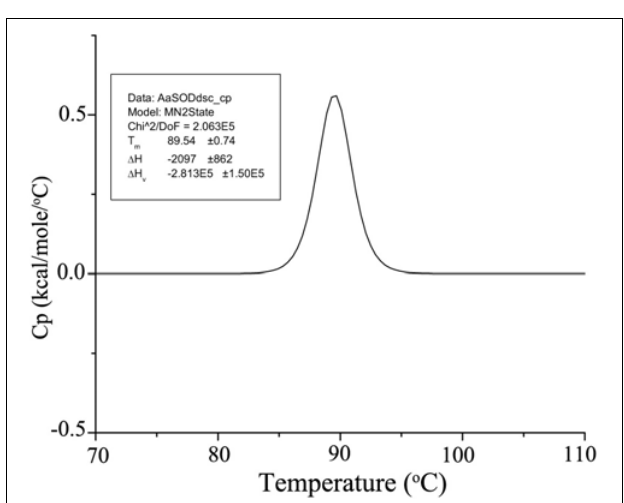
FIGURE 6 | DSC spectrum of Aa SOD. The purified Aa SOD was scanned from a temperature range of 70–110 ◦ C at a rate of 1.5 ◦ C min − 1 . The transition curve was fitted by non-2-state model and the T m value was calculated (MN2state) in the Origin